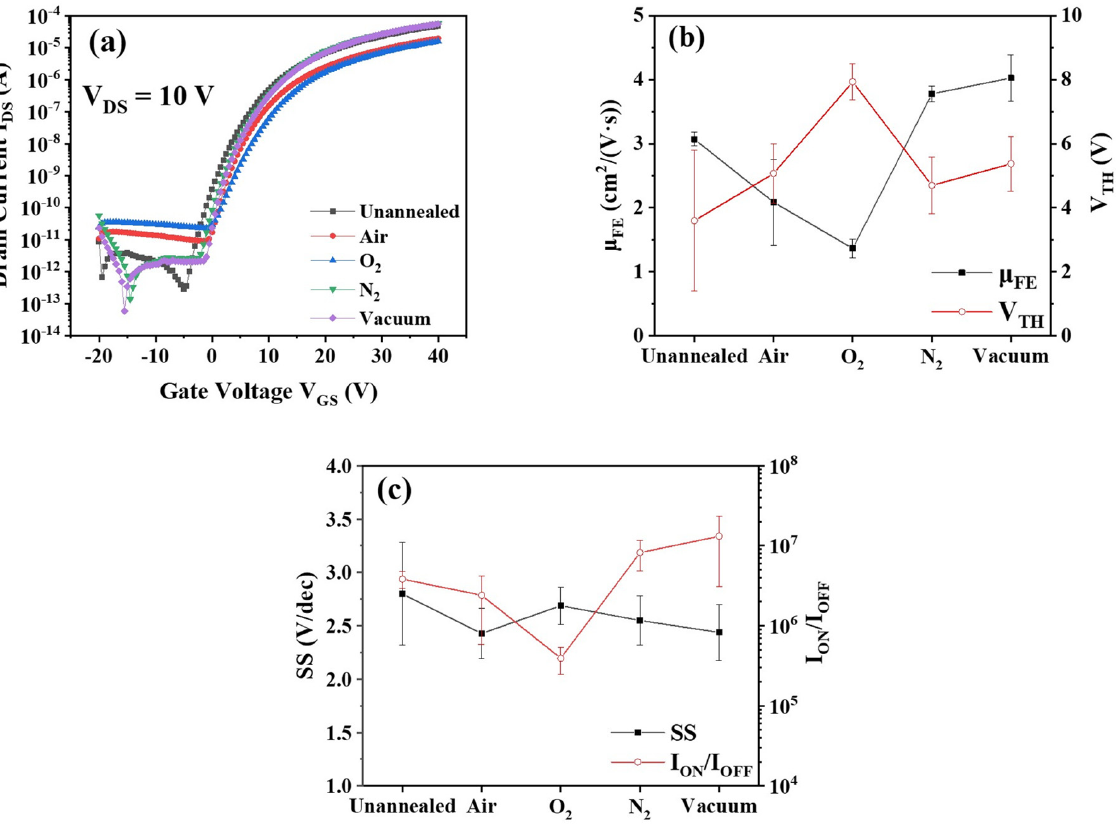
Figure 2. ( a ) Transfer curves; ( b ) mobility/threshold voltage; and ( c ) sub-threshold slope/on–off current ratio of the a-IGZO TFTs with SiO x passivation layers annealed in different atmospheres.